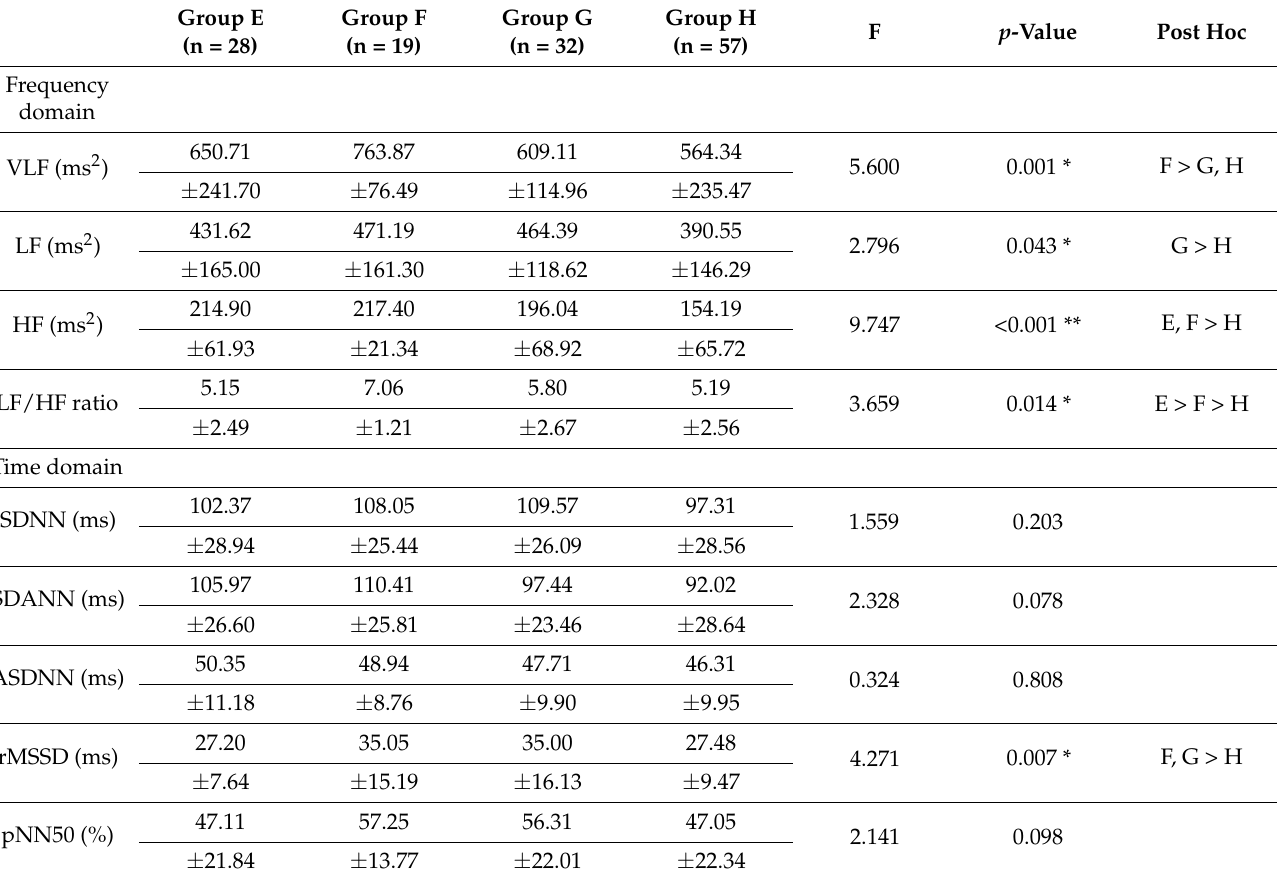
Table 4. Comparison of the HRV parameters between subgroups classified by somatic symptom